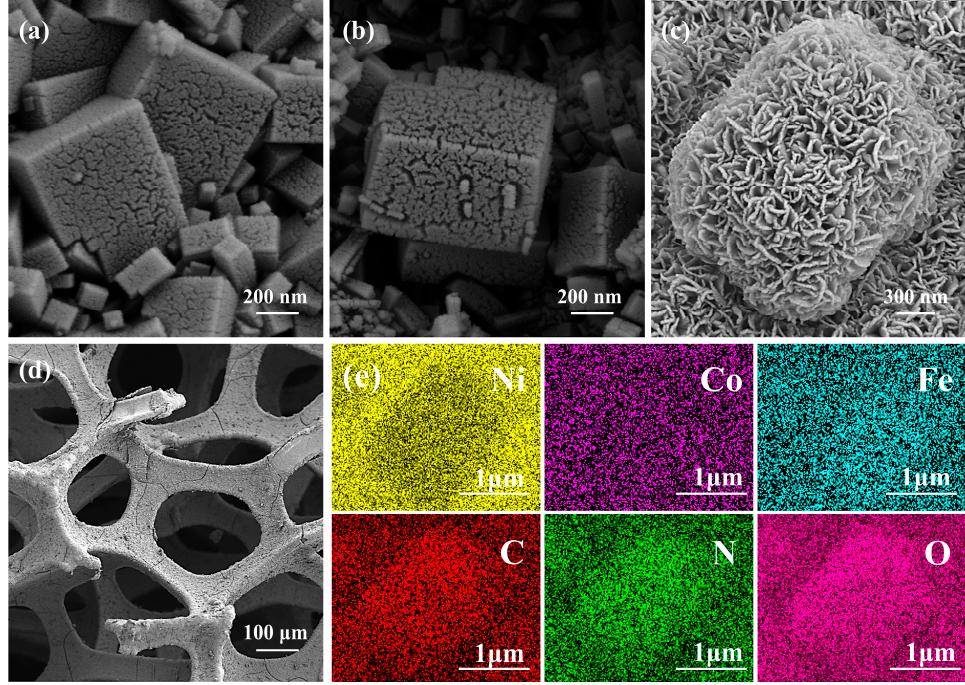
Figure 3. SEM images of ( a ), ( b ) Ni 2 Co 1 HCF/NF, ( c ) Ni 2 Co 1 HCF@CoNi-LDH/NF; ( d ) distribution